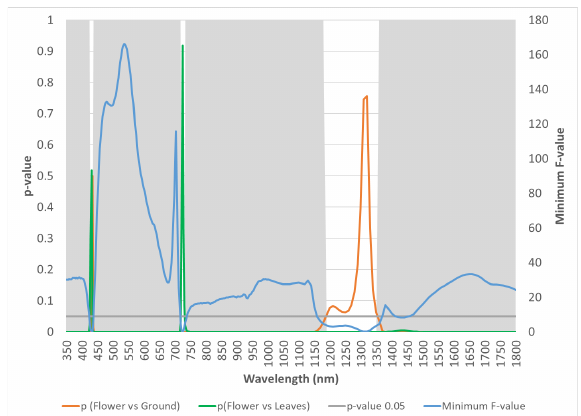
Figure 4. ANOVA assessment results. Numbers less than 0.05 represent a statistically significant separation. Areas shaded in grey show where the  -value is less than 0.05 between flowers and both ground and leaves. Blue line is the F-value.